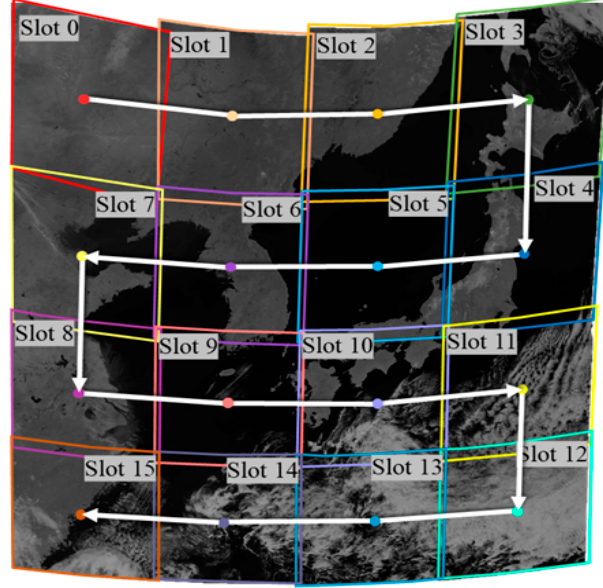
Figure 1. GOCI slot imaging sequence.